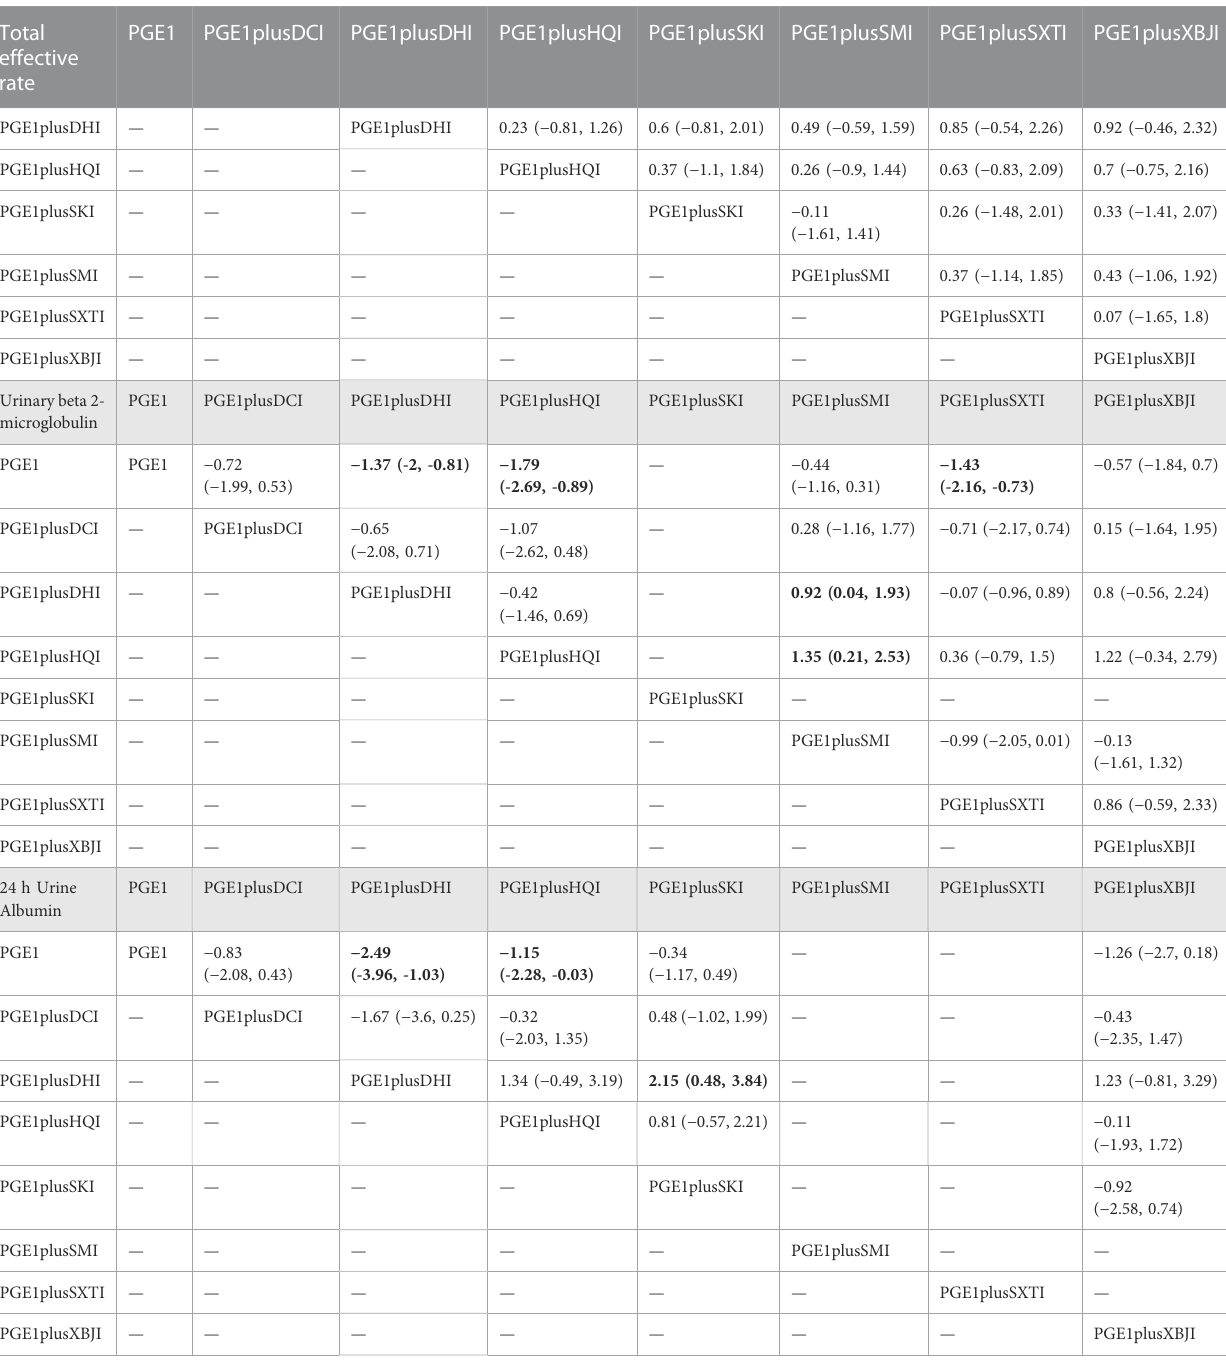
Xuebijing injection; PGE1, alprostadil